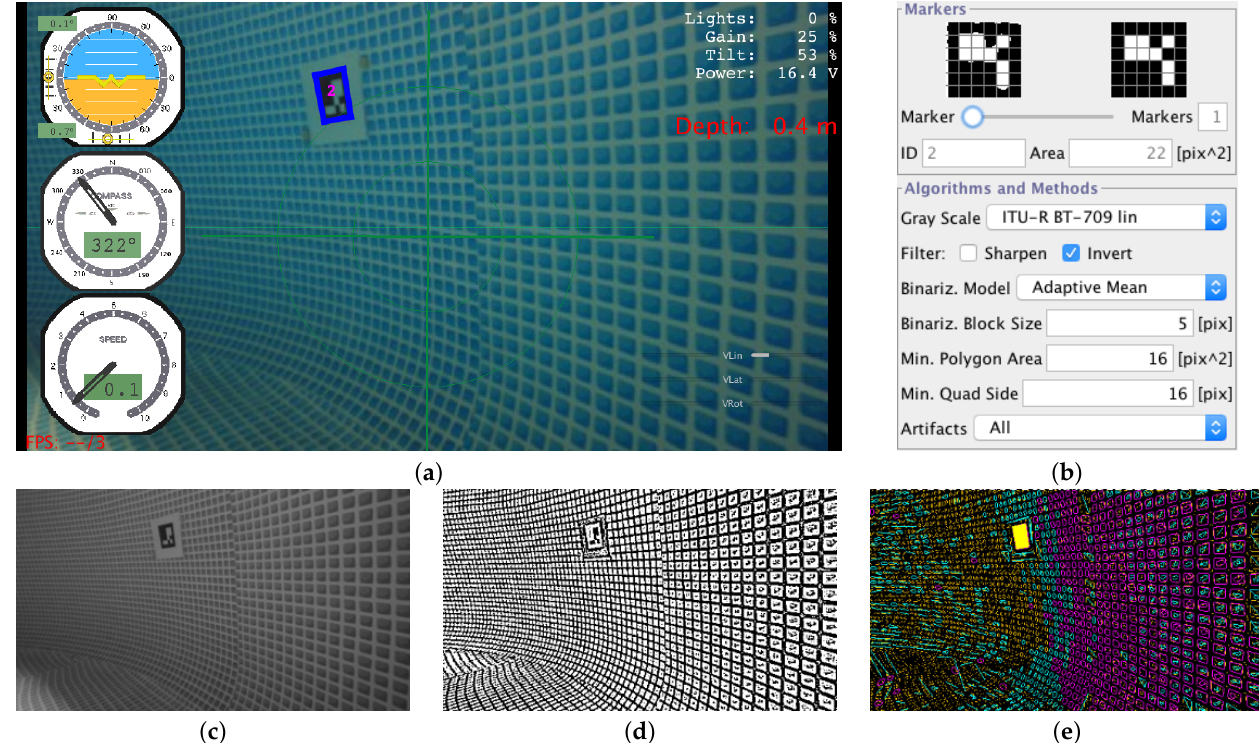
Figure 2. ( a ) Aruco marker with ID 2 detected by the on-board camera and ( b ) the on-line parameter configuration of maker recognition process with the ( c ) grayscale image, ( d ) binarized image, and ( e ) polygon extraction stage with marker